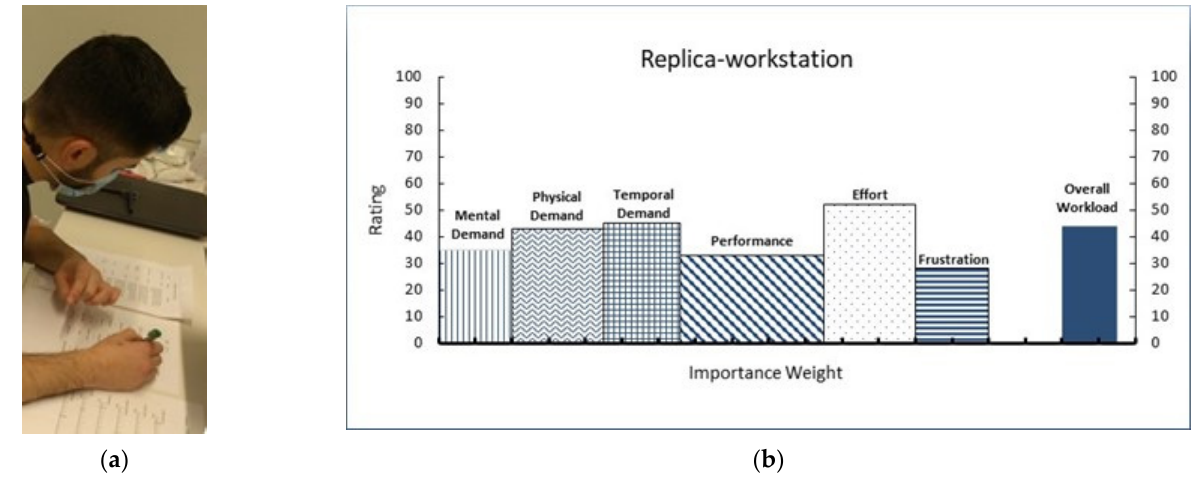
Figure 9. NASA-TLX results for the replica-workstation; ( a ) Questionnaire application; ( b ) Results.